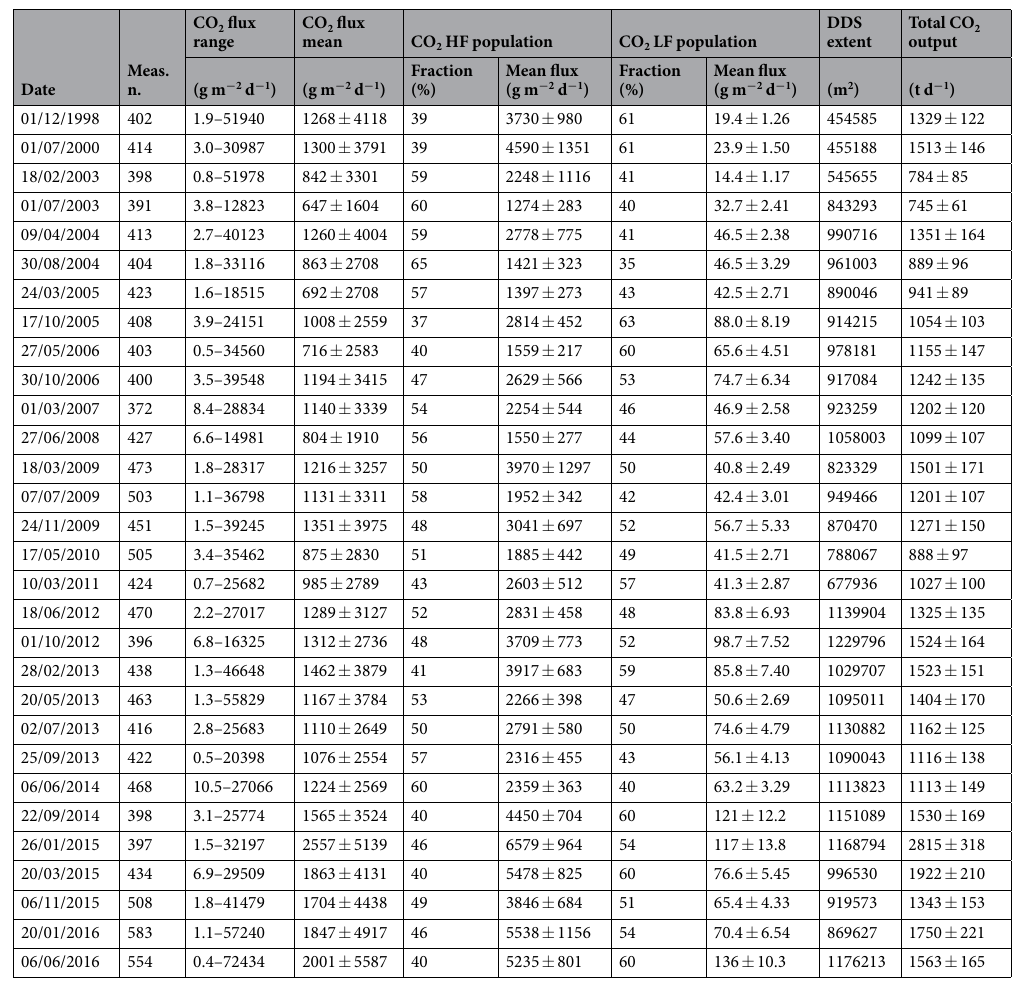
Table 1. Summary statistics of the CO 2 flux dataset, statistical parameters of the partitioned CO 2 flux populations, areal extents of the Solfatara DDS and total CO 2 output estimates. The measured CO 2 flux mean are presented as mean ± SD. The mean CO 2 flux of statistically partitioned population are presented as mean ± SD of the mean. The total CO 2 output is presented as mean ±